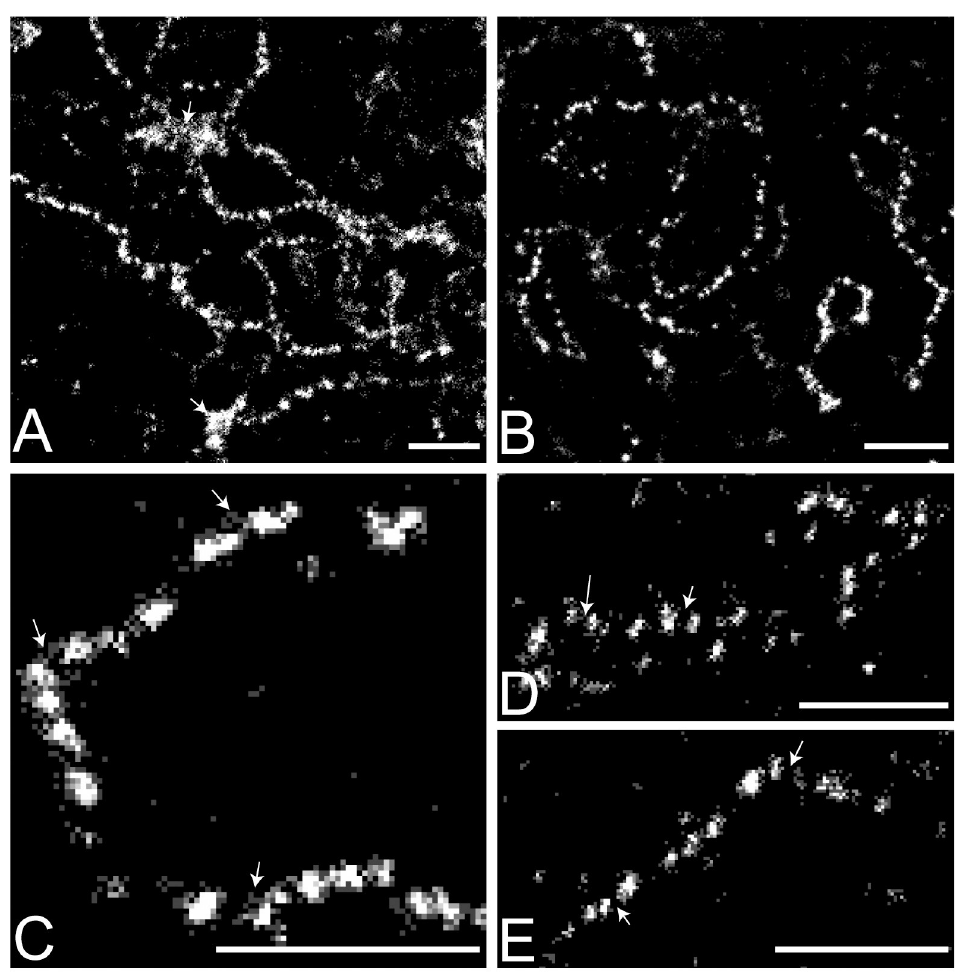
Fig 2. STORM super-resolution images of the Y loops. Histones are immunolabelled with pan-histone antibody, showing the clusters of nucleosomes. (A-C) Three representative examples of single slice images from different cells are shown increasing in magnification from A to C. The Y loops are largely made up of semi-regular clusters of nucleosomes. In A there are also some larger aggregates visible, indicated with arrows. In C the arrows indicate evidence of smaller looping regions of chromatin fibres between and extending from the nucleosome clusters. (D and E) Maximum projection images over 1.5 μ m of Y loop fibres showing that the clusters are genuine 3D objects as the regions in between clusters of nucleosomes do not fill in and form a complete contiguous fibre; examples indicated with arrows. Scale bars are 1 μ